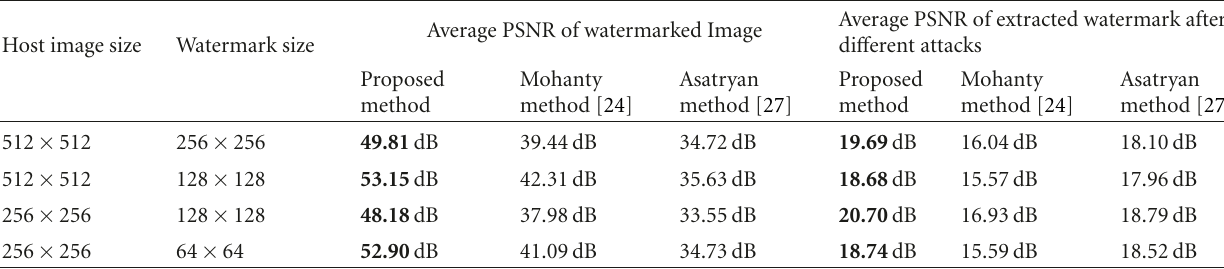
Table 4: Comparison of proposed method and two related methods.